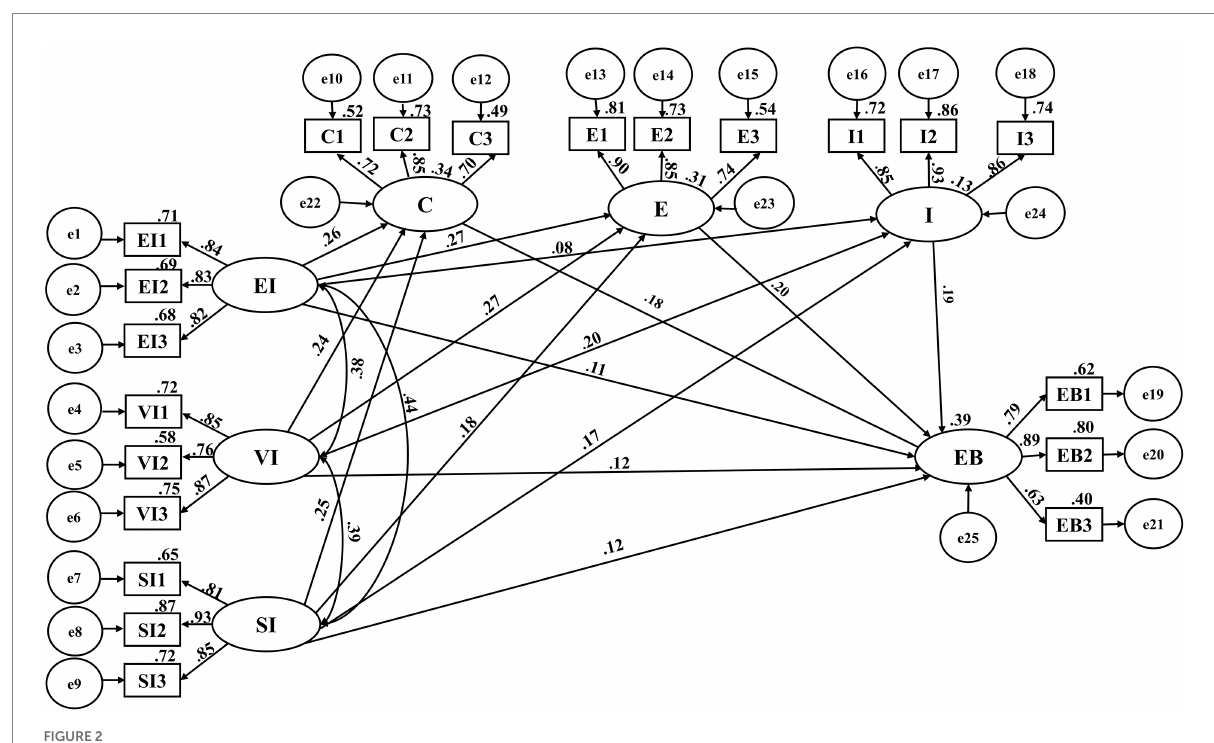
FIGURE 2 Estimation results of model path